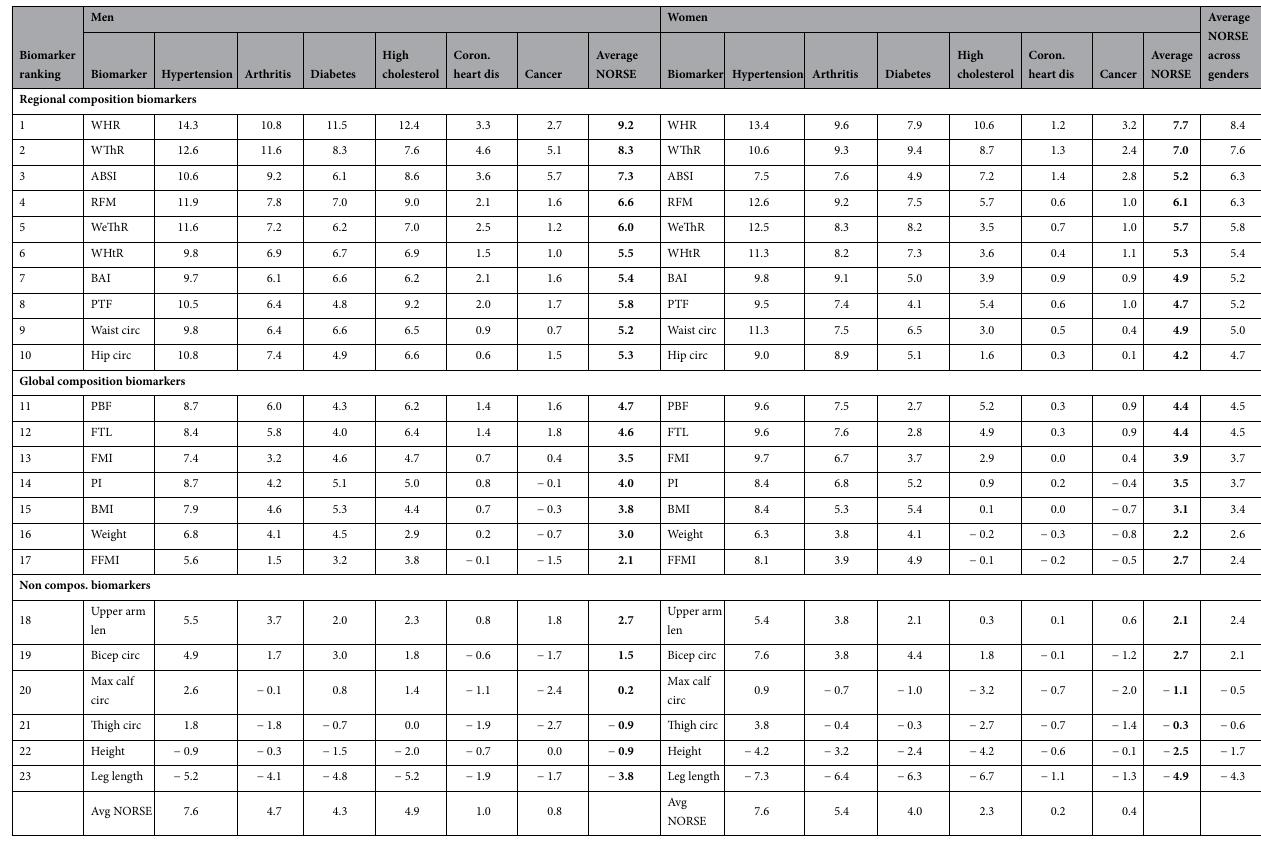
Table 1. Ranking of 1D biometric models. Normalized sensitivities (NORSE) values calculated for 23 different biomarkers (in rows) and 6 different conditions (in columns), for adult men and women. Average NORSE values for each gender are in